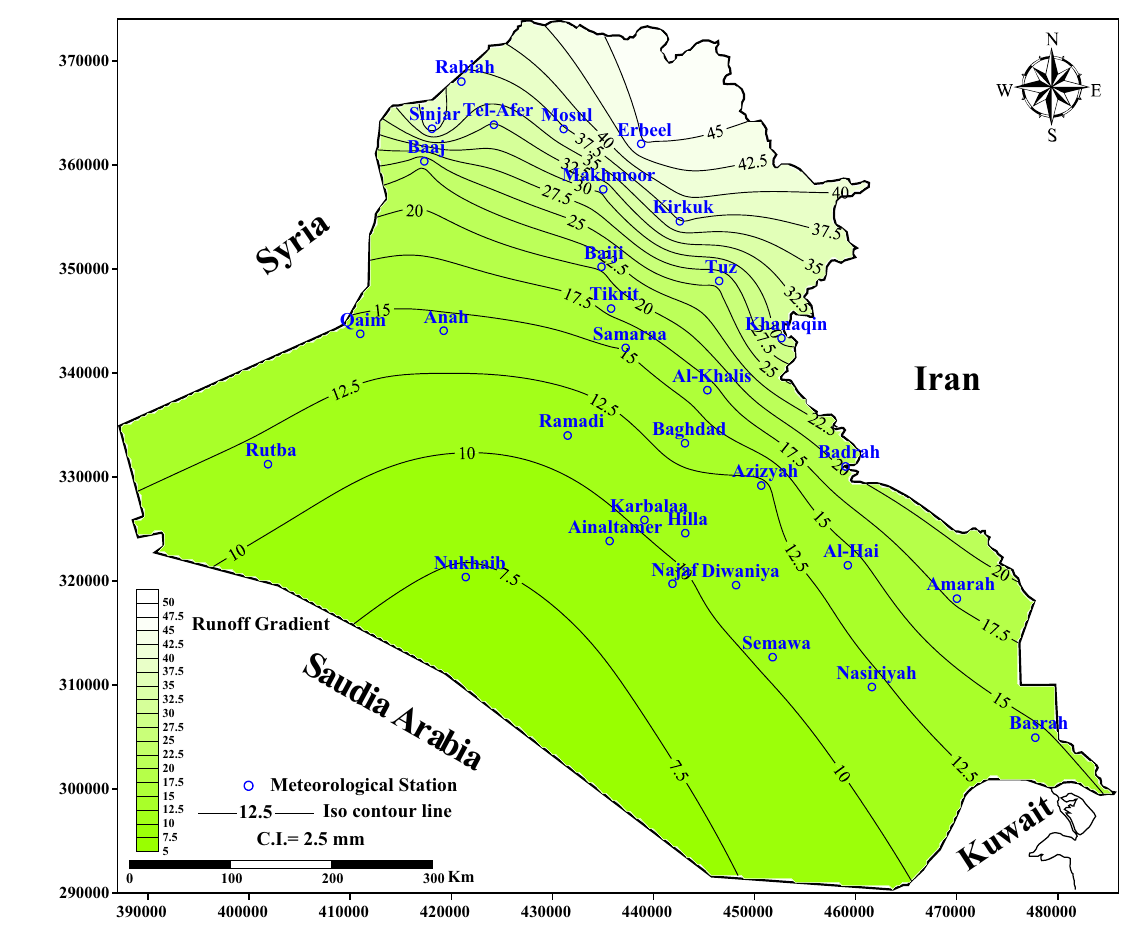
Fig. 6 Contour map of annual runoff in